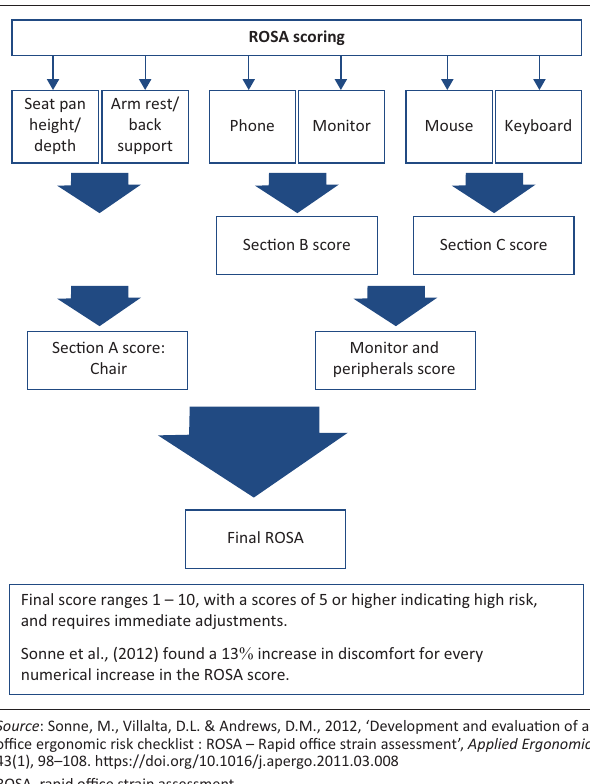
FIGURE 1: Diagrammatic presentation of the rapid office strain assessment scoring system.